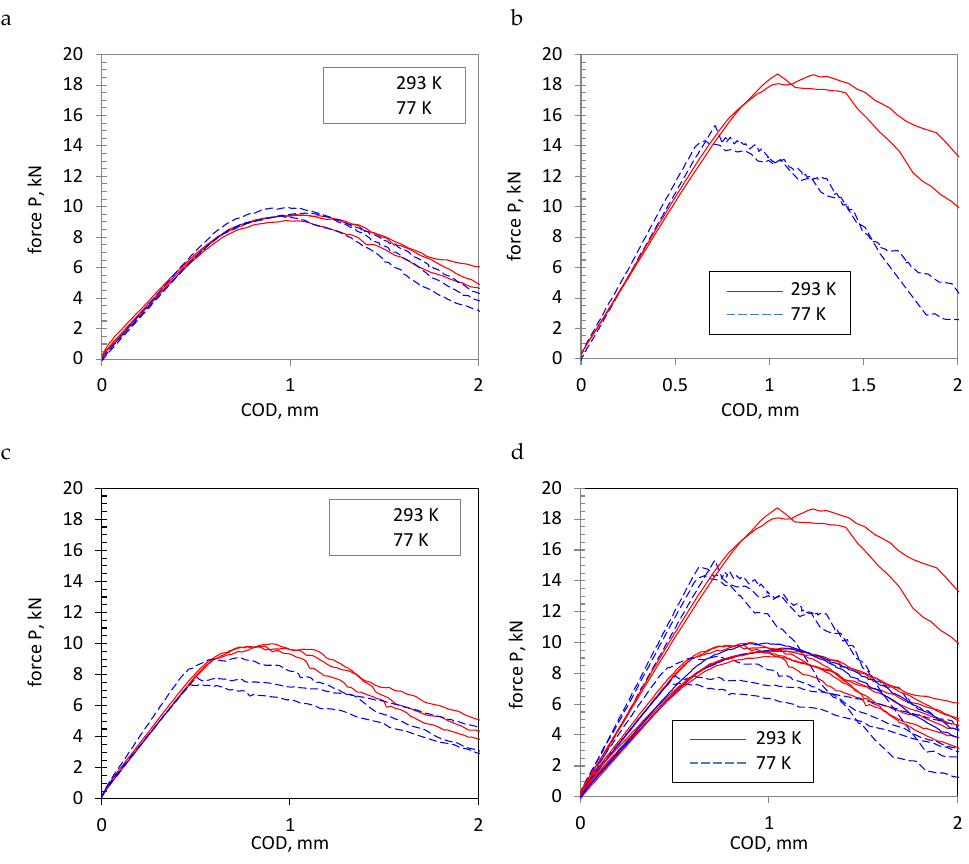
Figure 3. Diagrams of compact tension (CT) specimen loading in ambient and cryogenic temperatures: ( a ) AA2519 aluminum alloy, ( b ) Ti6Al4V titanium alloy, ( c ) AA2519–AA1050–Ti6Al4V layered material, and d) presentation of all test results.